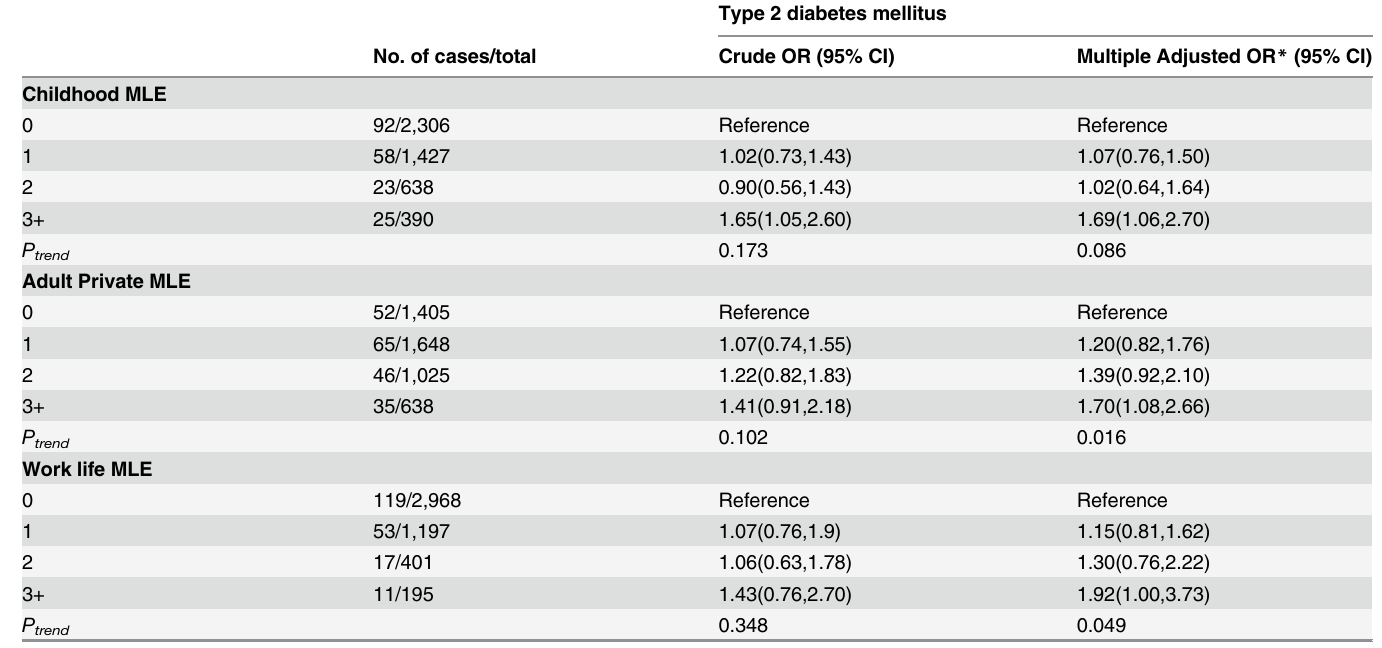
Table 2. Risk of incident type 2 diabetes mellitus among 4,761 men and women by number of major life events (MLE) in childhood, adult private life and work life Odds ratios (OR) and ± 95% confidence intervals (CI) are presented.